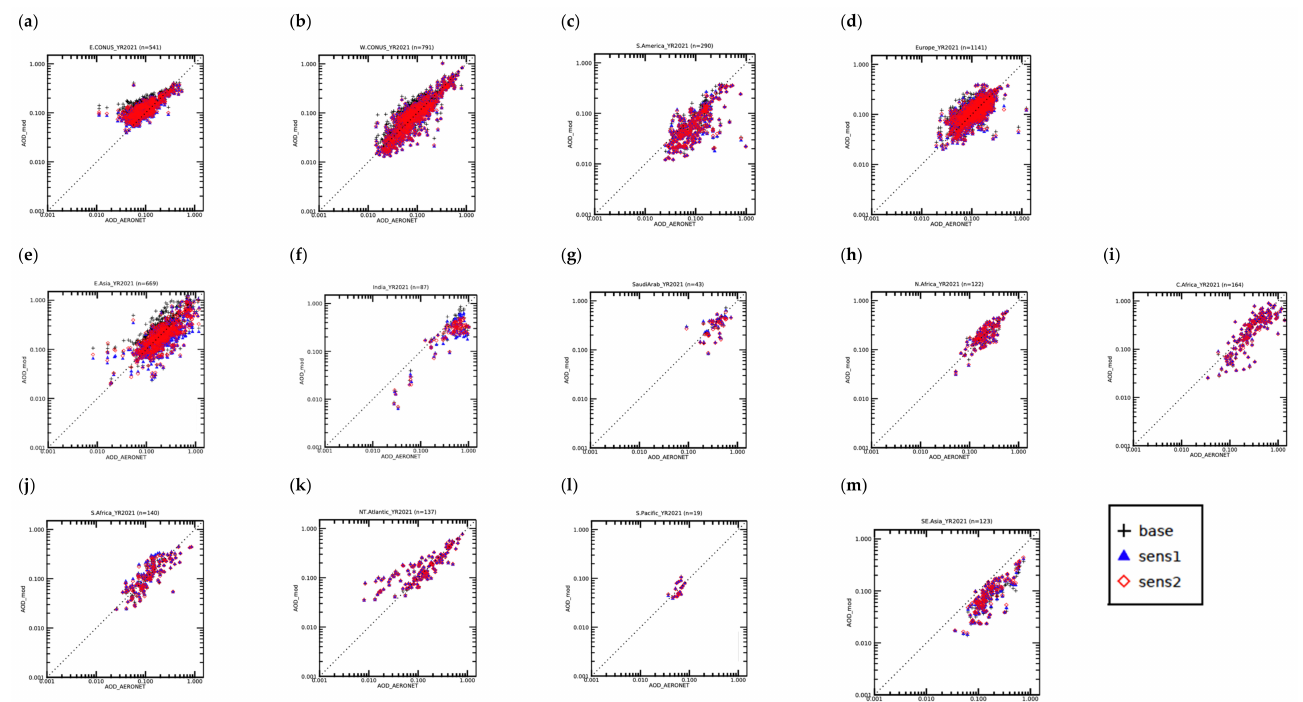
Figure 11. The scatter plots of the annual mean of GEFS AODs against AERONET AOD in 13 regions, including ( a ) East CONUS, ( b ) West CONUI, ( c ) South America, ( d ) Europe, ( e ) East Asia, ( f ) India, ( g ) Saudi Arabia, ( h ) Northern Africa, ( i ) Central Africa, ( j ) Southern Africa, ( k ) North Tropical Atlantic, ( l ) South Pacific, and ( m ) Southeast Asia, in 2021. The 1:1 dotted line is